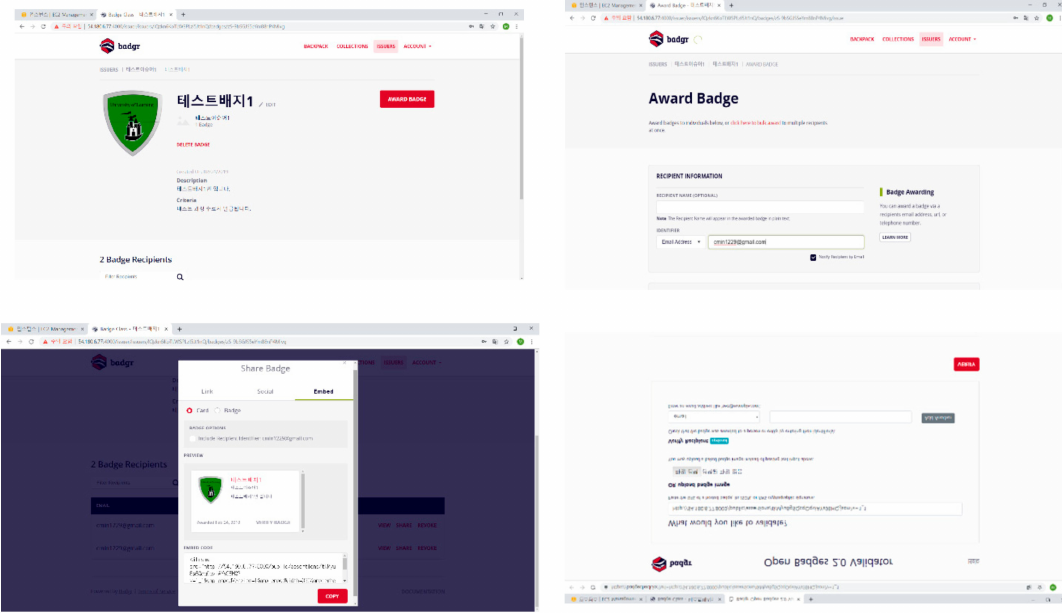
Figure 21. Badge award & validation (step